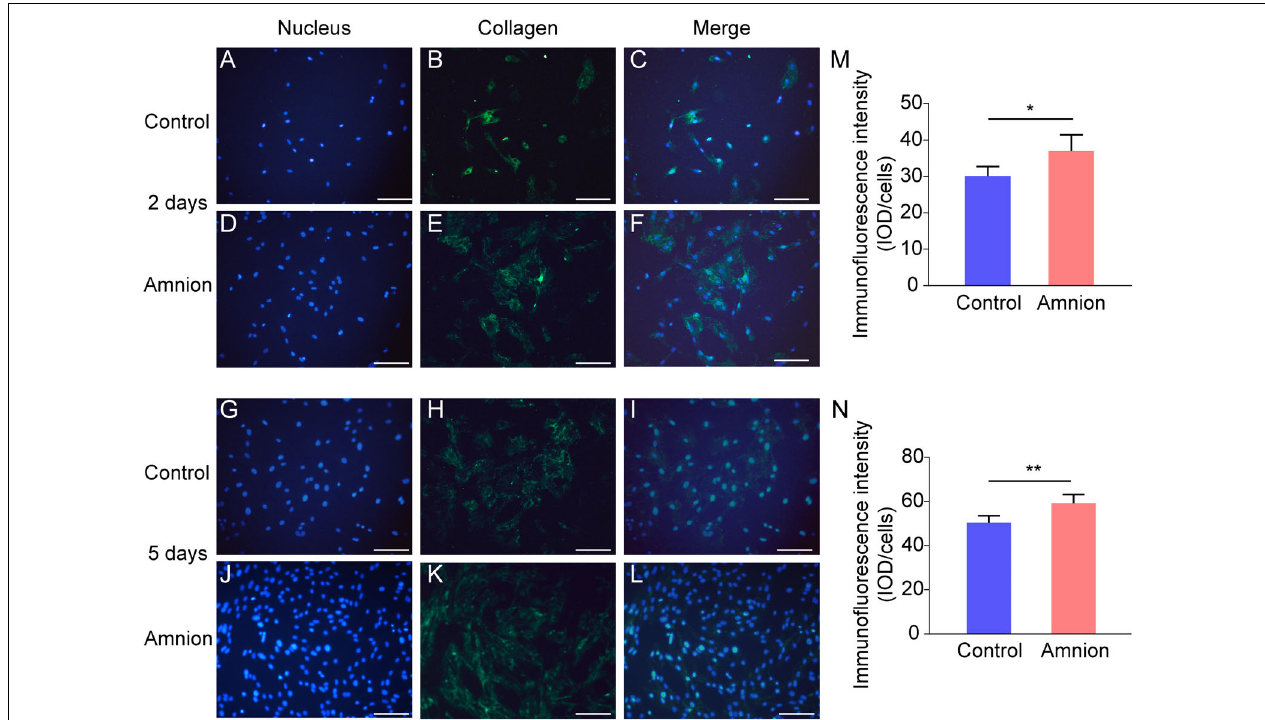
FIGURE 3 | Representative immunofluorescence images of collagen I. Fluorescent micrographs of tenocytes after 2 and 5 days of culture on the surface of a culture plate and acellular amniotic membrane. Tenocyte nucleus shape observed under a fluorescence microscope (A,D,G,J) . Collagen I presented positive after the fluorescent FITC mark was observed under a fluorescence microscope (B,E,H,K) . Tenocyte nucleus and collagen I merging (C,F,I,L) . The corresponding semi quantitative analysis of collagen fluorescence intensity in panels (M,N) (scale bar = 50 um, n = 5, * P < 0.05 and ** P <